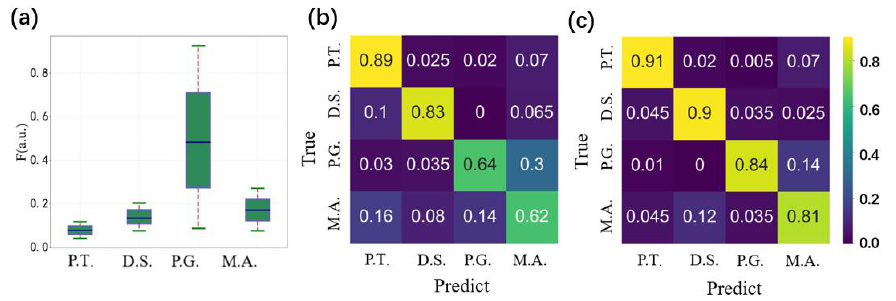
Figure 4. ( a ) Fluorescence distributions of different microalgae. ( b ) Classification confusion matrix using only polarization parameters. ( c ) Classification confusion matrix using both polarization and fluorescence parameters.